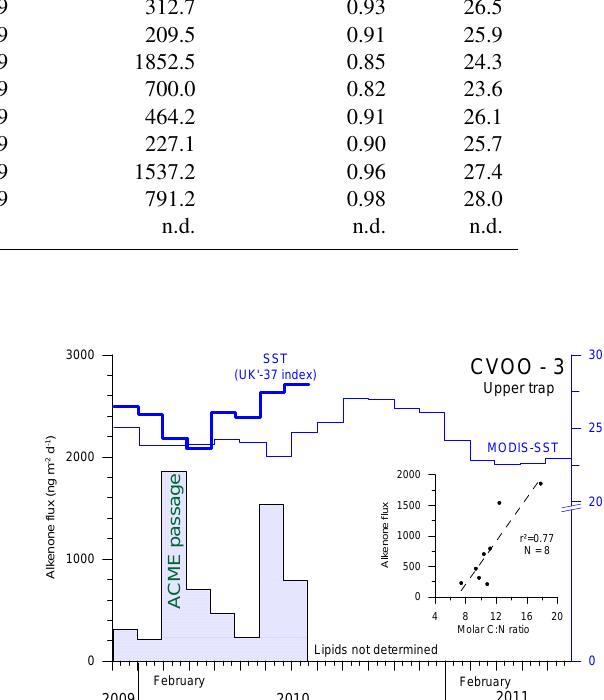
Figure 9. Alkenone fluxes together with the U k lite SSTs, for the time period before and after the ACME passage. Molar C:N ratios taken from Fig. 5b, which correlate well with the alkenone fluxes, are shown in the insert ( r 2 = 0.77, N = 8).